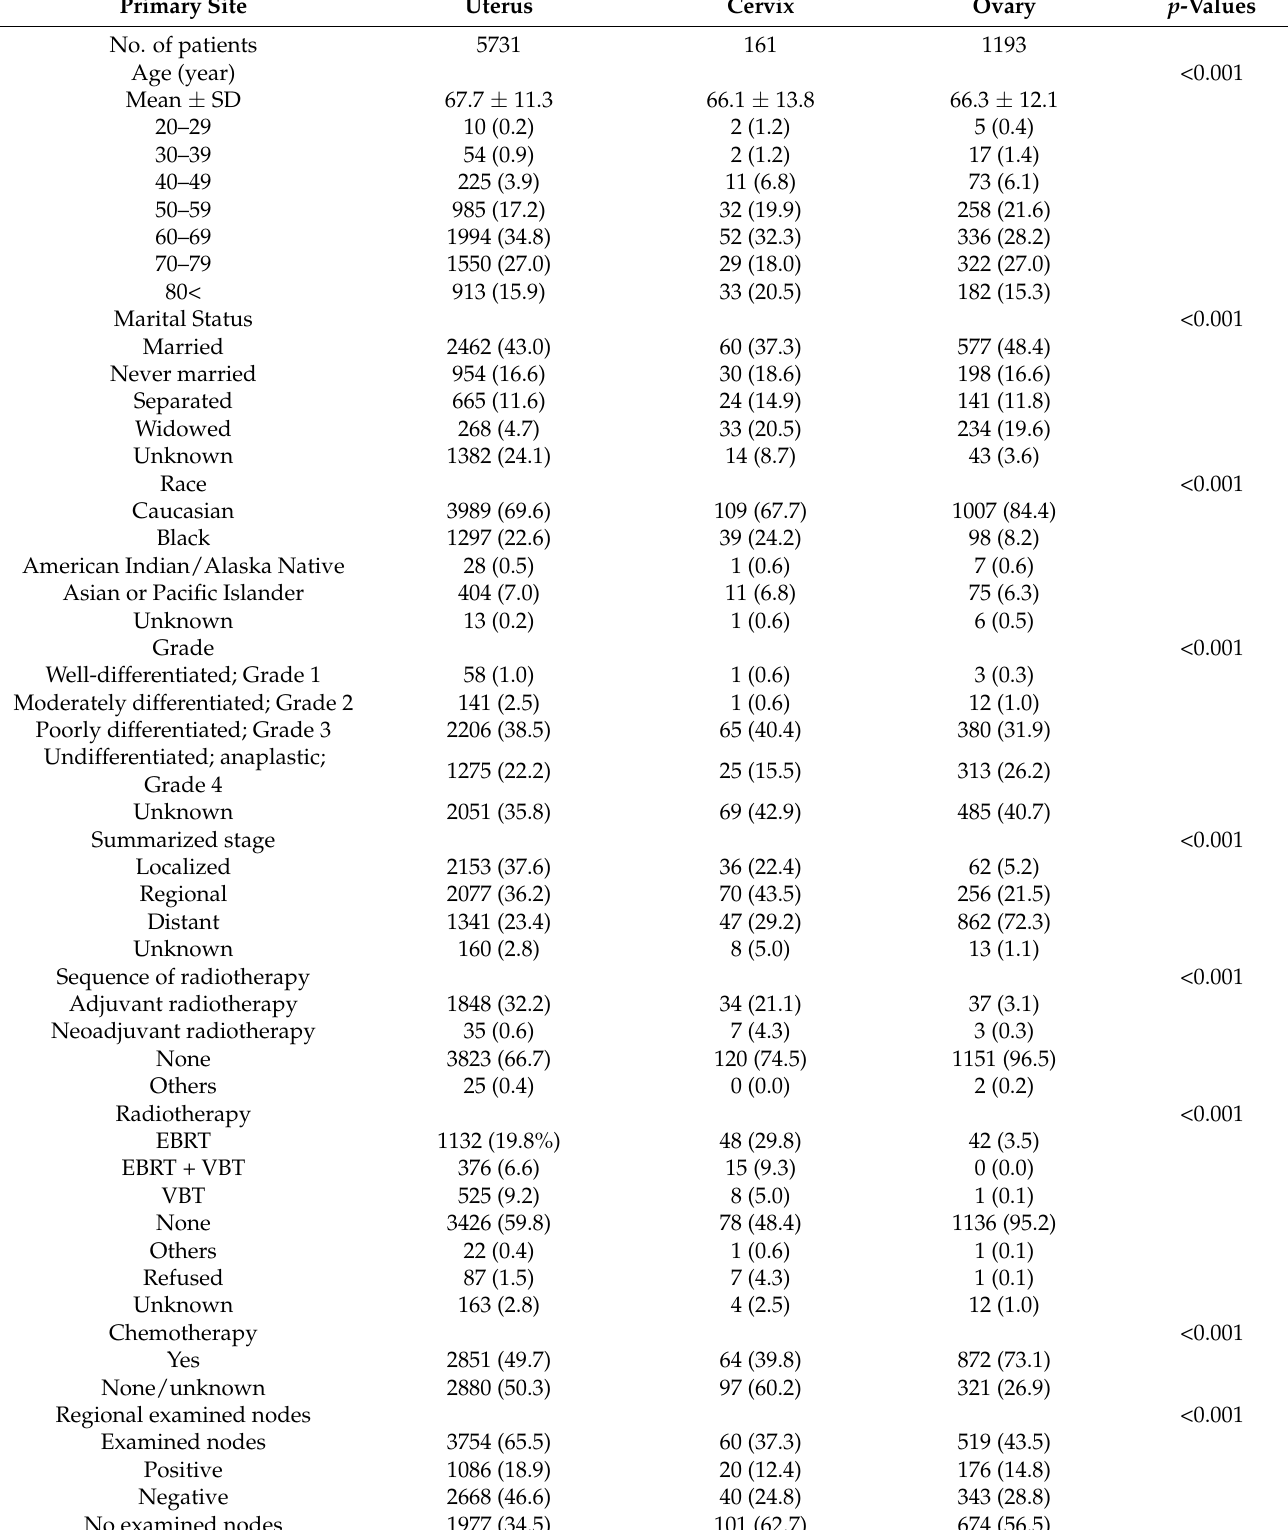
Table 1. Demographic characteristics of gynecologic